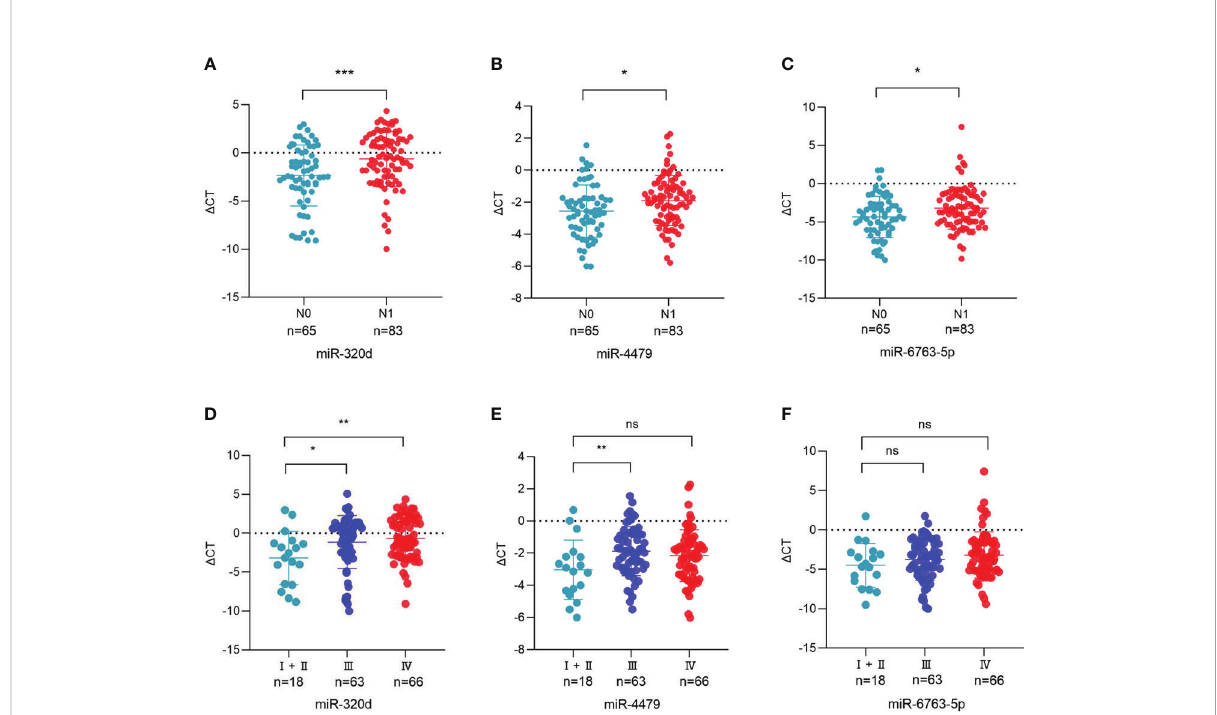
FIGURE 6 Association between the plasma exosomal miRNAs and the clinical data of EOC patients. (A-C) The statistical association between the levels of exosomal miR-320d, miR-4479, and miR-6763-5p and lymph node metastasis. (D-F) The plasma exosomal miR-320d, miR-4479, and miR-6763-5p expression in the FIGO stage. (* P < 0.05, ** P < 0.01, *** P < 0.001, ns: not signi fi cant). HD, Healthy donor; EOC, Epithelial ovarian